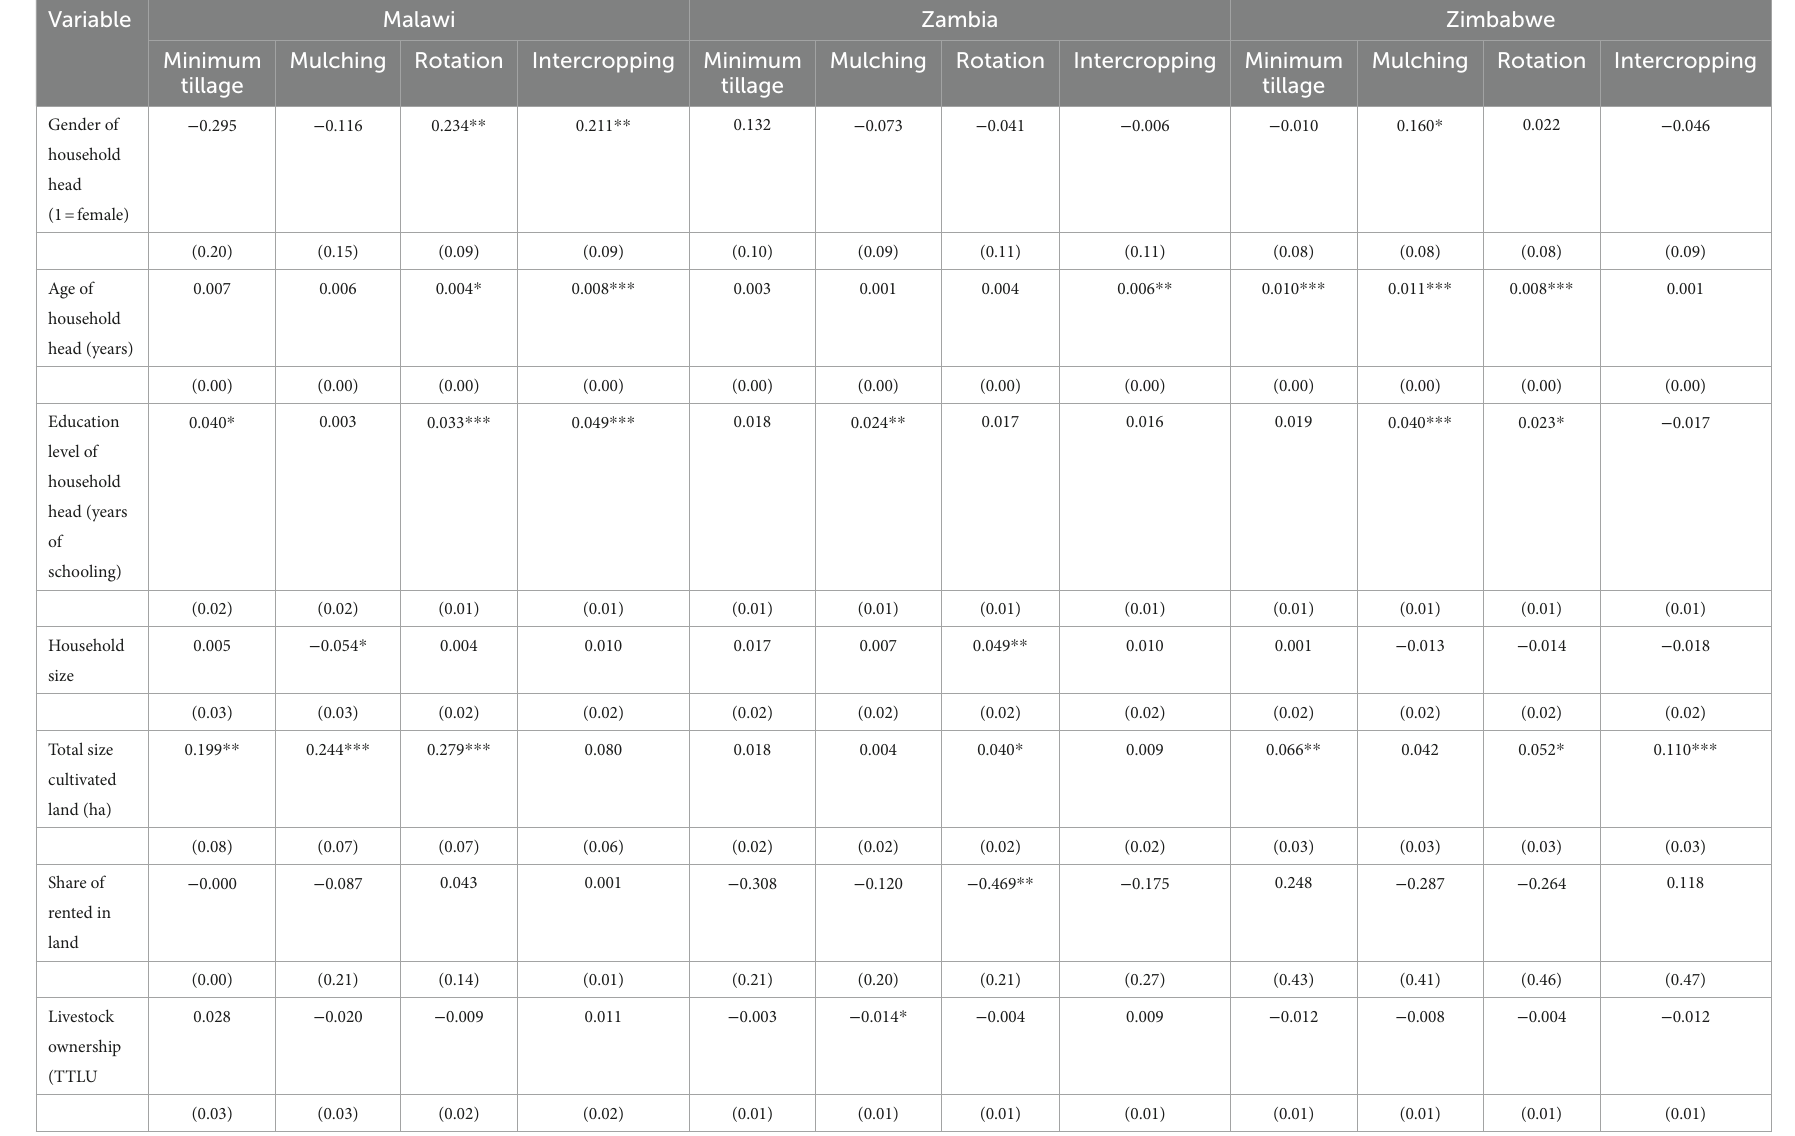
TABLE 12 Determinants of Adoption of CA practices: results of multivariate probit model estimation by